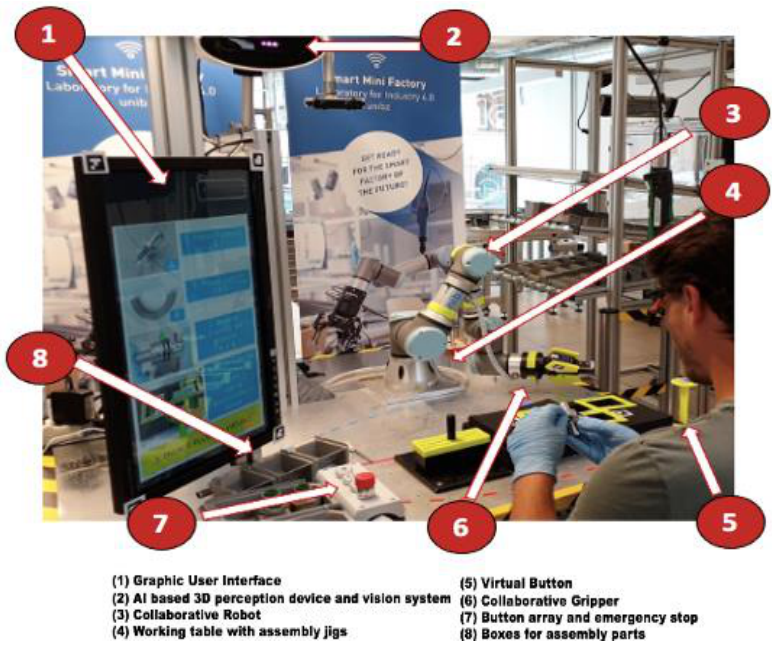
Figure 1. Workstation structure and components.